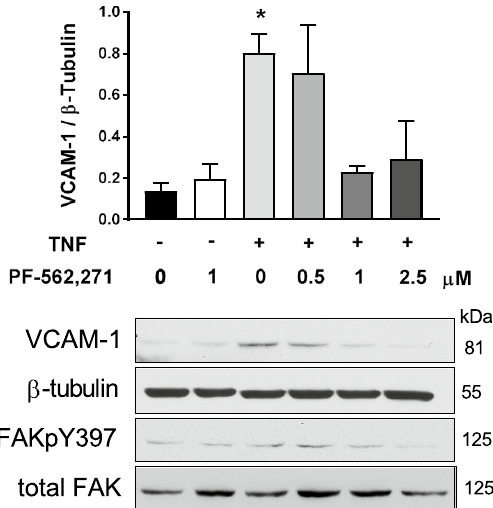
Figure 5. FAK activity mediates TNF-induced VCAM-1 upregulation. Confluent RBMECs were treated with vehicle or PF-562,271 (0.5–2.5 μM) for 1 h before cells were exposed to TNF (10 ng/ml) for 6 h. VCAM-1, FAKpY397, total FAK and β-tubulin protein levels were evaluated by western blotting. One-way ANOVA *P < 0.05 vs. no TNF and no